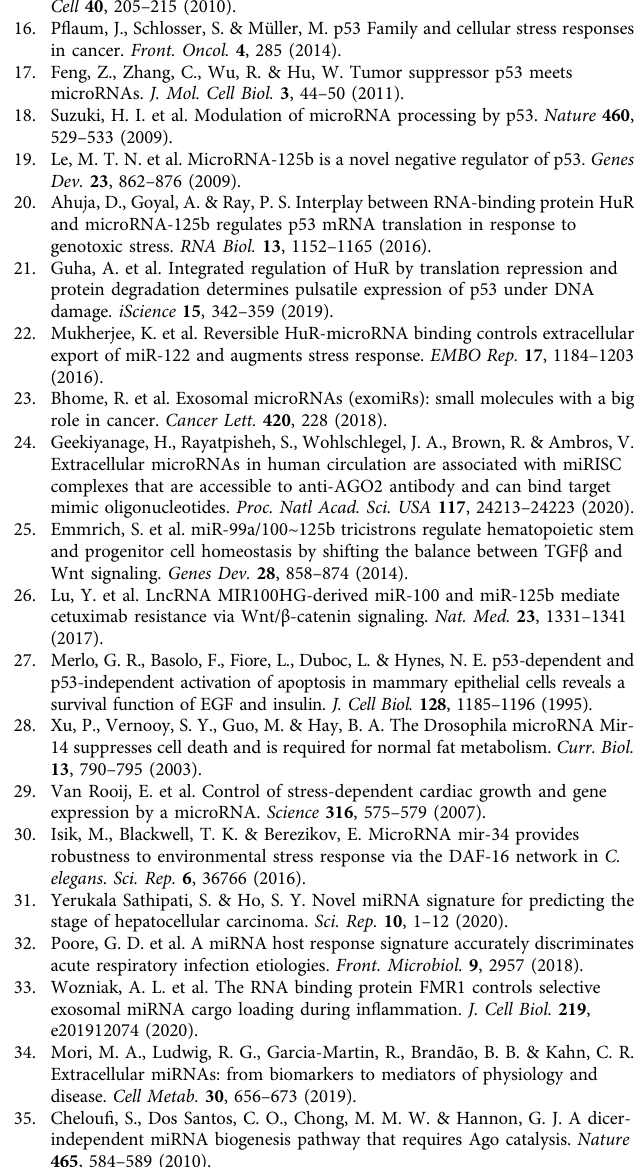
Fig. 7 Biphasic dynamics of miR-125b regulates pulsatile expression of p53 and HuR post-UVC irradiation. a Overlapping double negative and negative feedback loops between HuR, miR-125b, and p53 mediated by exosomal export, transcriptional upregulation, miRNA processing and translation repression. b Representative immunoblots of cytoplasmic lysates from MCF7 cells exposed to UVC irradiation, and either untreated or treated with 20 µ M GW4869 or 20 µ M pi fi thrin α and collected at different time points post-UVC exposure, with p53, HuR, and GAPDH antibodies (left). Graphical representation of the change of p53 and HuR protein levels, normalized to GAPDH protein levels, over time post-UVC irradiation in the absence or presence of GW4869 or pi fi thrin α treatment (right). c qRT-PCR of total RNA isolated from UVC-irradiated MCF7 cells, either untreated or treated with 20 µ M GW4869 or 20 µ M pi fi thrin α , collected at indicated time points post-UVC exposure using miR-125b-speci fi c primers. miR-125b RNA levels were normalized to U6B snRNA levels. Data represent fold change of normalized miR-125b RNA level in UVC-treated cells taking 0 h miR-125b RNA level for each treatment as 1. Mean± s.d. from three independent experiments are represented. * signi fi es P value ≤ 0.05, ** signi fi es P value ≤ 0.01, and *** signi fi es P value ≤ 0.005 (paired two-tailed t -test) from respective 0 h controls. d Estimation of miR-125b from UVC-irradiated MCF7 cells, transfected with control siRNA or HuR siRNA, collected at indicated time points till 6 h post-UVC irradiation. miR-125b RNA levels were normalized to U6B snRNA levels. Mean± s.d. from three independent experiments are represented. # Signi fi es P value ≤ 0.05 and ### signi fi es P value ≤ 0.005 (paired two-tailed t -test) from Ctrl. siRNA transfected cells and ** signi fi es P value ≤ 0.01 and *** signi fi es P value ≤ 0.005 from 0 h control. e Immunoblots of lysates from UVC-irradiated MCF7 cells, transfected with control siRNA or HuR siRNA, collected at indicated time points till 6 h post-UVC irradiation with p53, HuR, and GAPDH antibodies. f Schematic representation of the pulses of p53 and HuR and the biphasic expression of miR-125b in cells in response to DNA damaging UVC radiation. g Molecular mechanisms consisting of exosomal export, transcriptional upregulation, and miRNA processing temporally regulating the biphasic expression dynamics of miR-125b in the 2 – 12 h post-exposure to UVC irradiation which contributes to the feedback loops generating the pulses of p53 and